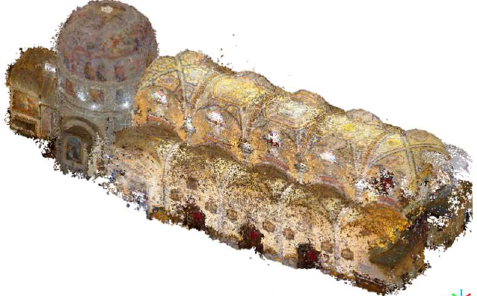
Figure 15. The dense point cloud generated using 76 spherical images.